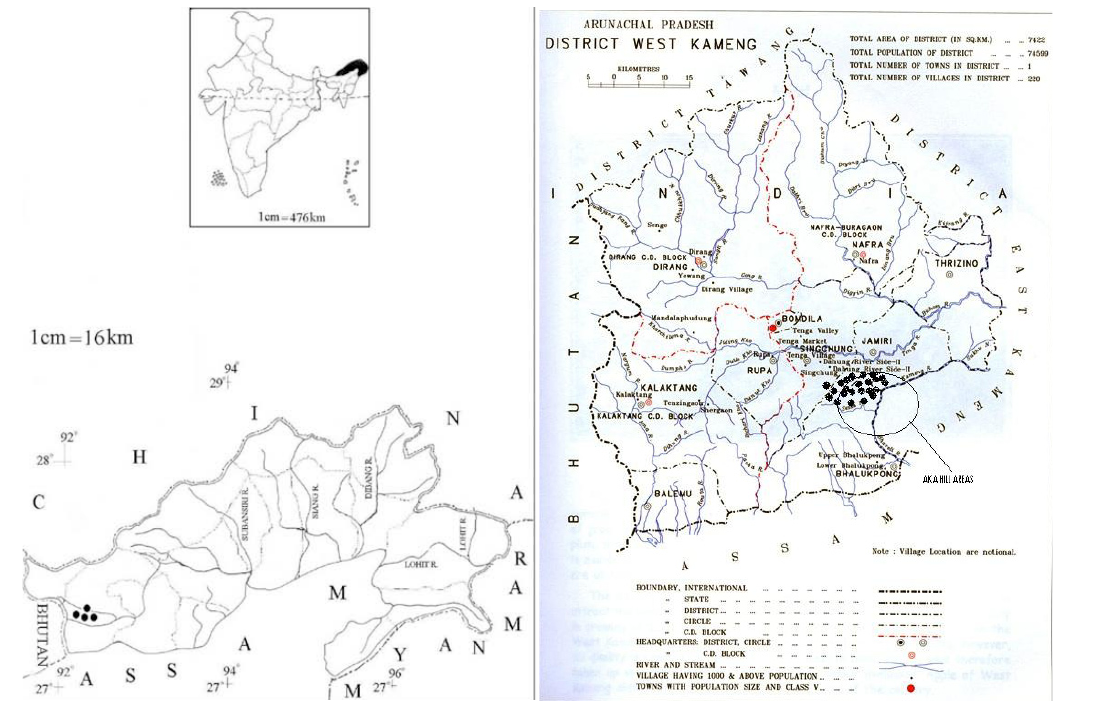
Figure 2. distribution of Gaultheria akaensis in West Kameng district (magnified) of Arunachal Pradesh